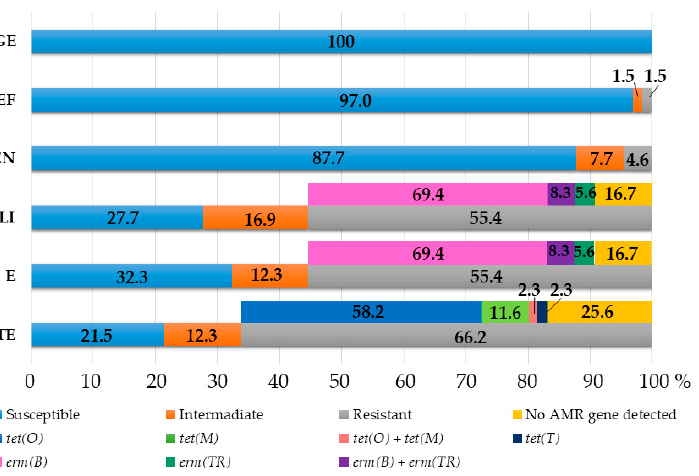
Figure 1. The overall rate of susceptibility and resistance to antimicrobials and AMR gene detection in 65 S. canis strains. GE—gentamicin, CEF—cephalothin, P—penicillin G, CLI—clindamycin, E—erythromycin, TE—tetracycline. 2.2. Detection of Tetracycline, Macrolide and Lincosamide Resistance Genetic Determinants